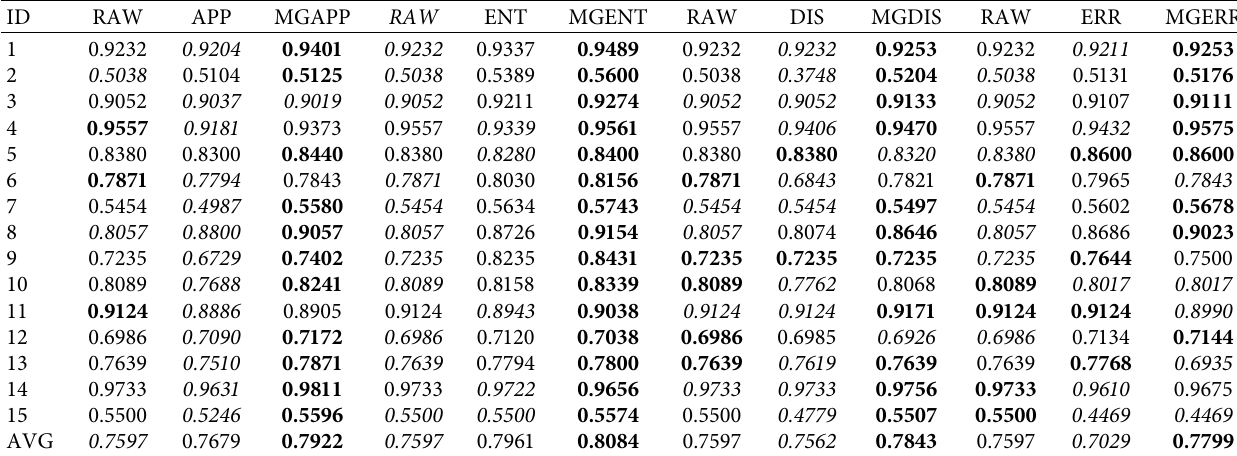
Table 5: Comparisons among the classification accuracies with using NEC.